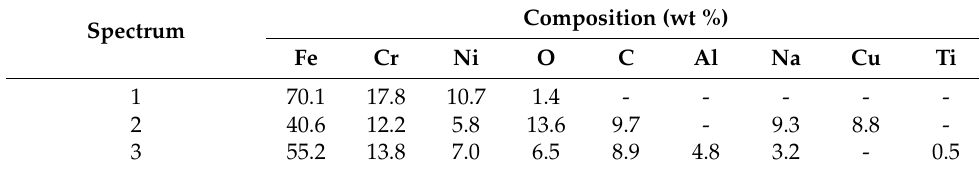
Table 3. EDX analysis results of the SS/Al intermetallic compound (IMC) layer from sample 1.